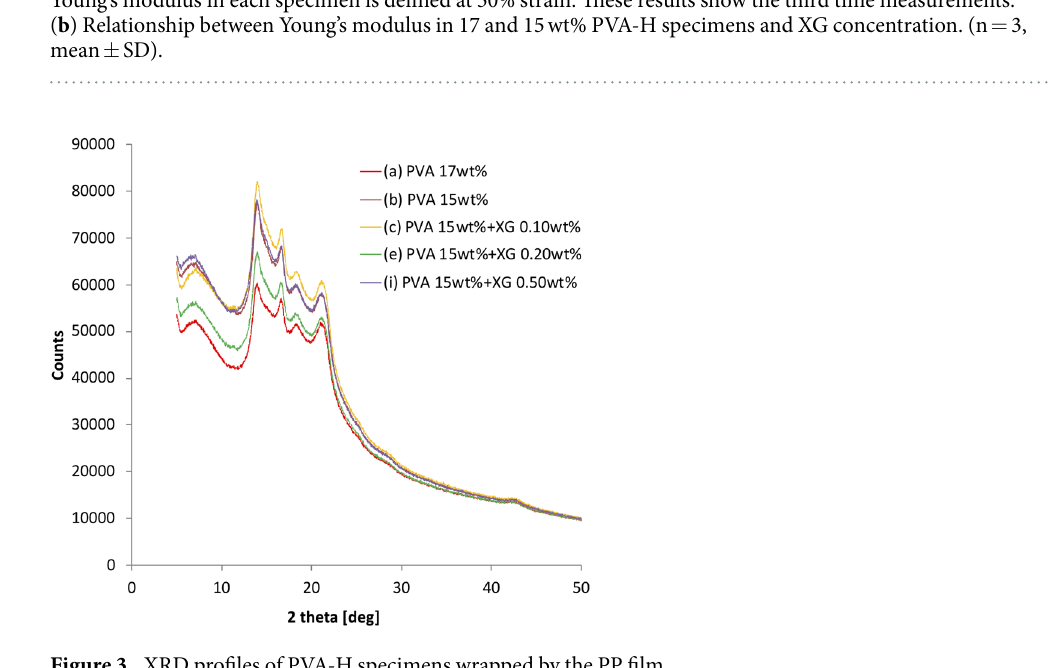
Figure 3. XRD profiles of PVA-H specimens wrapped by the PP